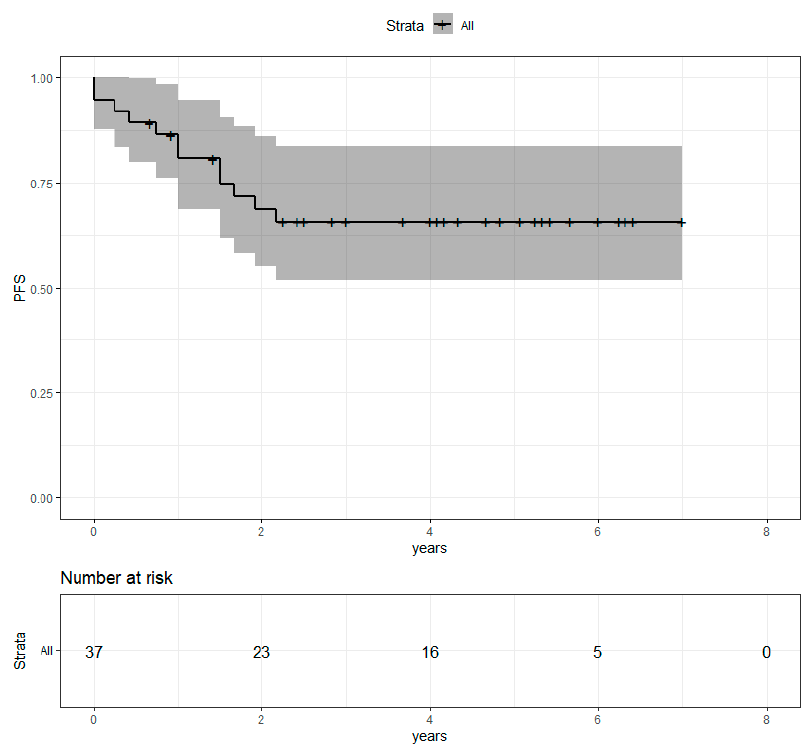
Figure 2. Overall survival of the population with metastatic disease at the time of diagnosis after concomitant RT and Pertu/Trastu dual HER2 blockade. Confidence intervals are provided in grey.